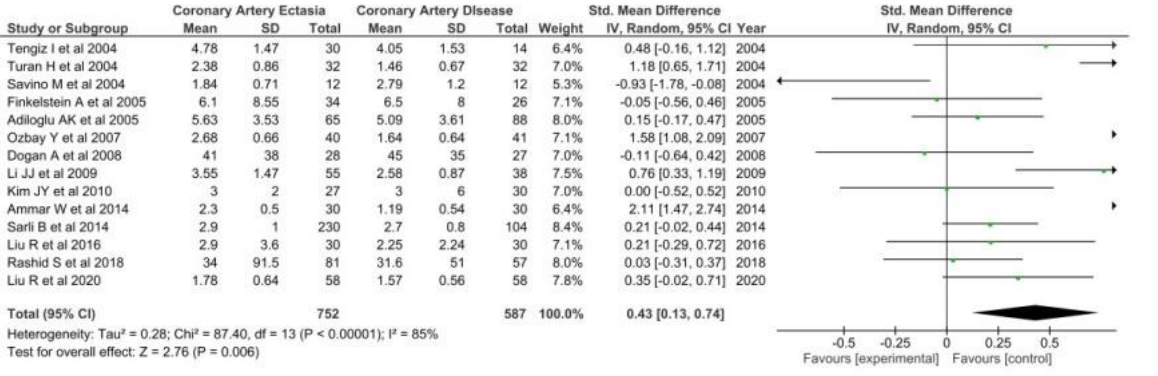
Figure 3. hs-CRP in CAE patients versus controls (top) and CAE versus CAD patients